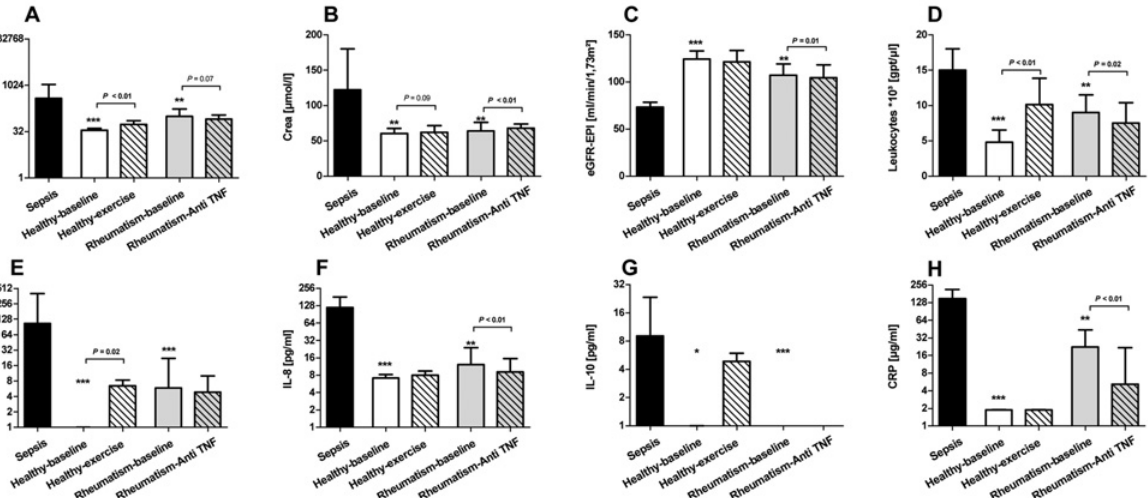
Fig 1. Laboratory finding of patients with sepsis, healthy controls and patients with rheumatic disease. Patients with sepsis (n = 15) are presented with black, healthy controls (n = 8) before inflammatory stimulus by exercise with white open bars and after stimulus with white striped bars and patients with rheumatic disease (n = 23) before treatment with an anti-TNF agent with grey open bars and after treatment with grey striped bars. (A) Plasma-NGAL levels, (B) plasma creatinine levels (Crea), (C) estimated glomerular filtration rate (eGFR-EPI), (D) leukocyte count in whole blood, (E) plasma interleukin 6 levels (IL-6), (F) plasma interleukin 8 levels (IL-8), (G) plasma interleukin 10 levels (IL-10) and (H) plasma levels of C-reactive protein (CRP) are presented. * P < 0.05, ** P < 0.01, *** P < 0.001 compared to sepsis or indicated by clamp to corresponding group. Cytokine detection limits were 2.5 pg/ml for IL-6, 3.6 pg/ml for IL-8 and 3.3 pg/ml for IL-10. Bars and error bars represent median values and interquartile